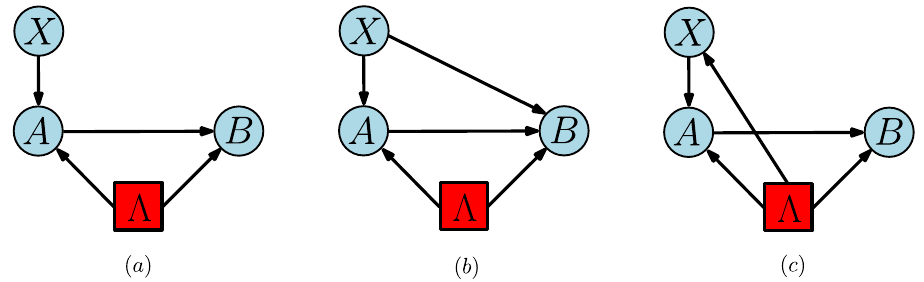
Figure 1: Causal graphs describing the instrumental scenario and its relaxations. Circular nodes correspond to observed variables, and rectangular ones are latent. Directed edges represent the causal links. ( a ) The instrumental scenario: the controlled variable X is completely independent of a latent variable Λ . ( b ) A relaxed instrumental scenario, where